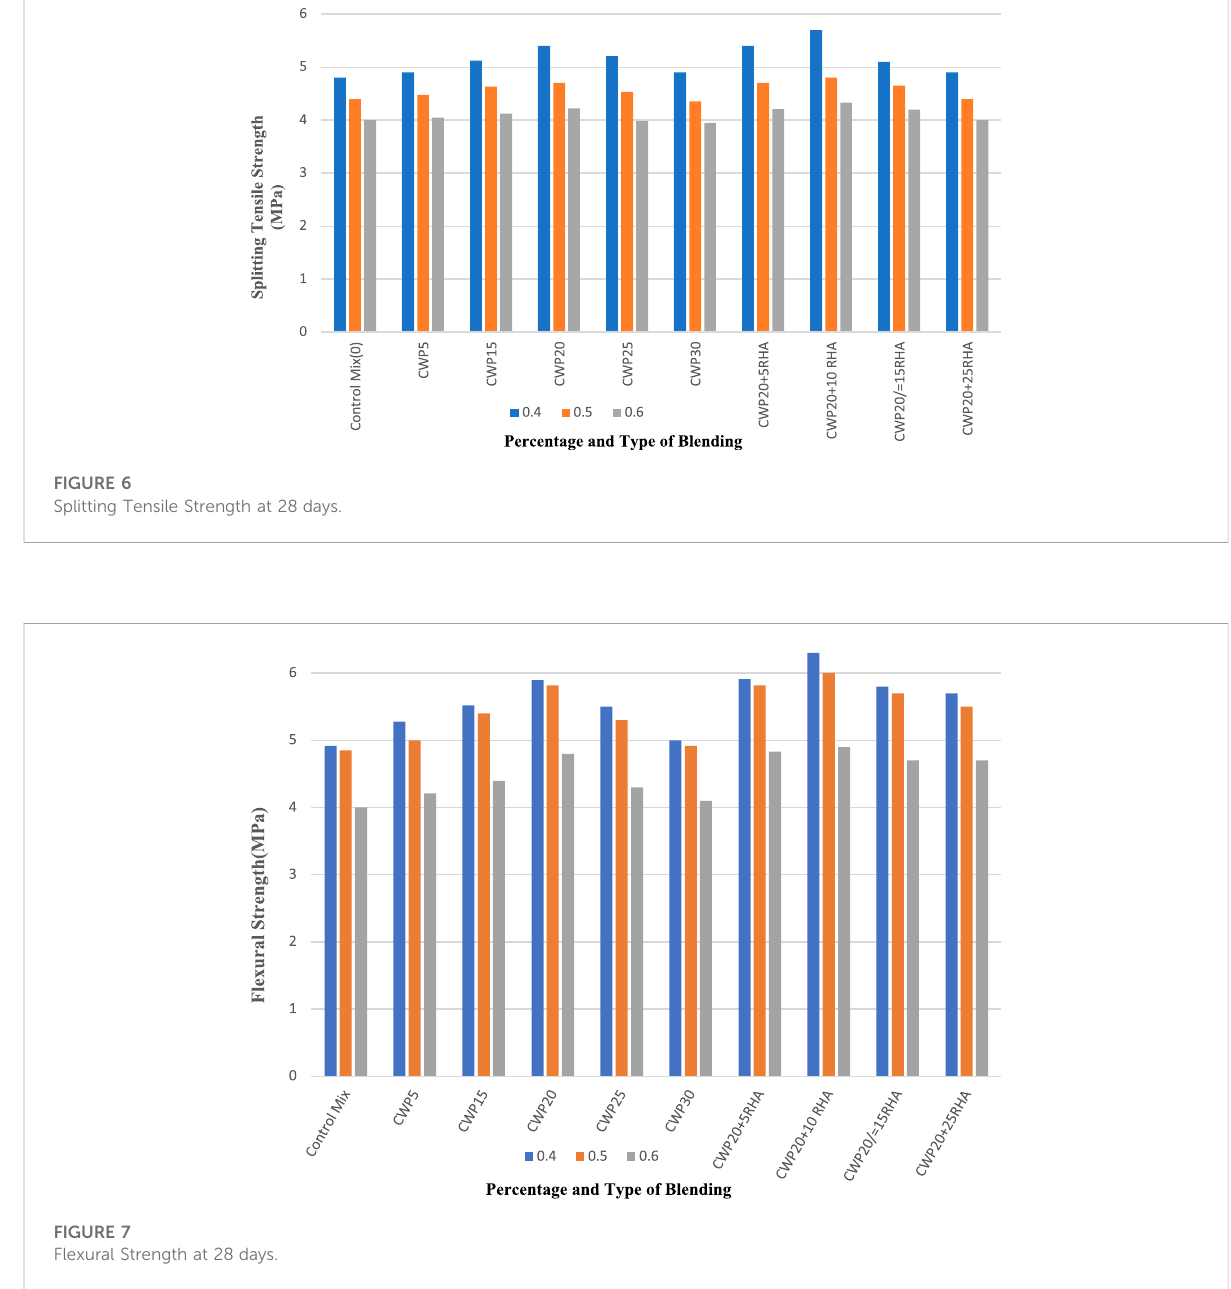
FIGURE 7 Flexural Strength at 28